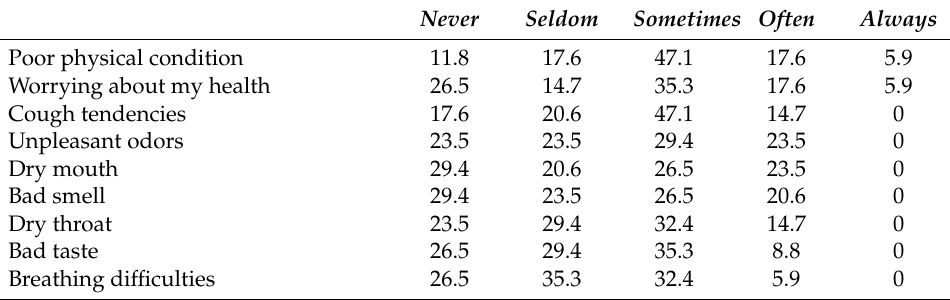
Table 3. Distributions of responses (in %) of current smokers ( n = 34) for several experienced disadvantages (on a scale from never to always ) due to smoking. Never Seldom Sometimes Often Always Poor physical